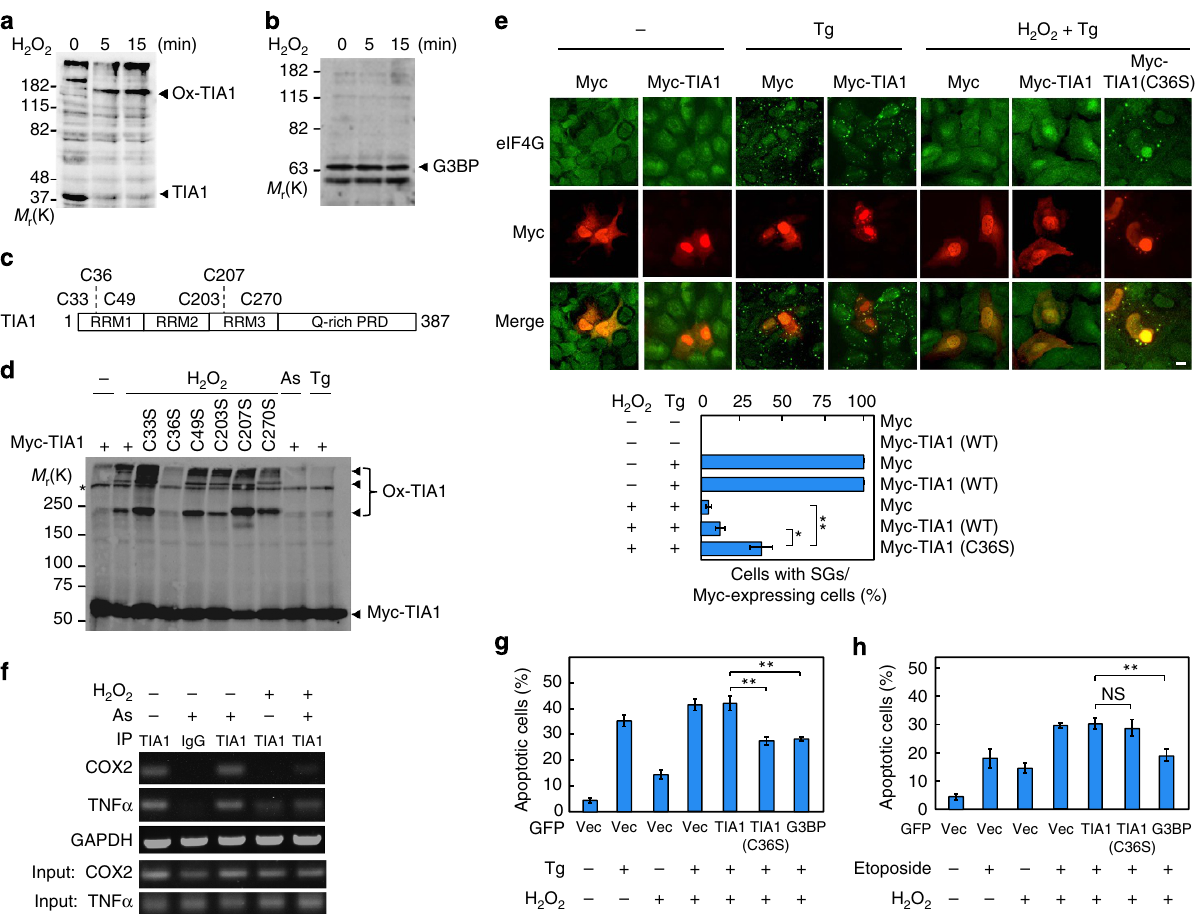
Figure 2 | TIA1-Cys36 is oxidized by H 2 O 2 and SG formation is suppressed. ( a , b ) COS cells were stimulated with 1mM H 2 O 2 for the indicated times and cell extracts were prepared under non-reducing conditions. ( a ) Endogenous TIA1 was probed by immunoblotting using anti-TIA1 antibody. Ox-TIA1, oxidized TIA1. ( b ) Endogenous G3BP was probed with anti-G3BP antibody. ( c ) Schematic structure of the TIA1 protein. PRD, prion-related domain. ( d ) Myc-tagged TIA1 point mutants were transiently transfected into U2OS cells. After 36h, the cells were treated with 1mM H 2 O 2 , 0.5mM As or 1 m M Tg for 50min. Cell extracts were prepared and Myc-TIA1 was probed with anti-Myc antibody under non-reducing conditions. ( e ) U2OS cells were transiently transfected as indicated. After 36h, cells were treated with 1 m M Tg either alone or simultaneously with 200 m M H 2 O 2 for 50min. Myc-TIA1 and endogenous eIF4G were visualized by immunofluorescence. Scale bar, 10 m m. The percentage of Myc-expressing cells containing SGs was determined and is shown in the graph. Error bars indicate s.e.m. ( n ¼ 4). * P o 0.02, ** P o 0.01, Student’s t -test. ( f ) U2OS cells were treated with 200 m M H 2 O 2 and 0.5mM as indicated, and were incubated for 50min. A RIP assay was performed using anti-TIA1 antibody with rabbit IgG as a negative control. ( g , h ) Apoptosis induced by Tg was suppressed in cells expressing TIA1(C36S). U2OS cells were transfected as indicated (Vec, vector) and were cultured for 36h. Cells were then treated with 10 m M Tg and/or 200 m M H 2 O 2 ( g ) or with 50 m M Etoposide and/or 200 m M H 2 O 2 ( h ) for another 20h. To assess apoptosis, cells were stained with Annexin V-Cy3 and visualized by fluorescence microscopy. The number of red-positive apoptotic cells per GFP-positive green cells was determined. About 500 GFP-expressing cells were scored to calculate the percentage of apoptotic cells. Error bars indicate s.e.m. ( n ¼ 4). ** P o 0.01. NS, not significant, Student’s t